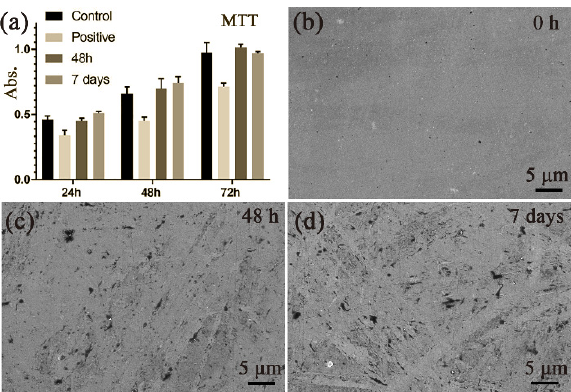
Figure 3. Biocompatibility test results of TiNi SMA prepared by LSF. ( a ) MTT test results of cell growth curve; ( b ) SEM image of sample surface morphology before MTT biological cell activity detection; ( c , d ) SEM images of the samples at 48 h and 7 days after MTT biological cell activity detection.